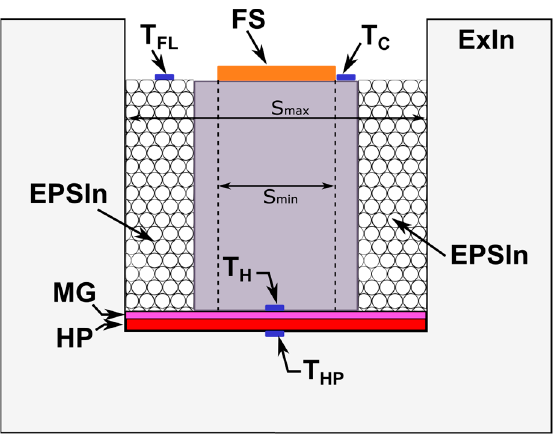
Figure 4. Ambient hot-box schema including the thermal insulation elements and sensors.